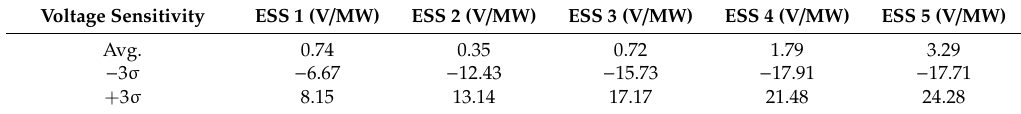
Figure 11. Distributions of voltage sensitivity deviation. Table 2. 3-Sigma value of voltage sensitivity deviation depending on the connection point of